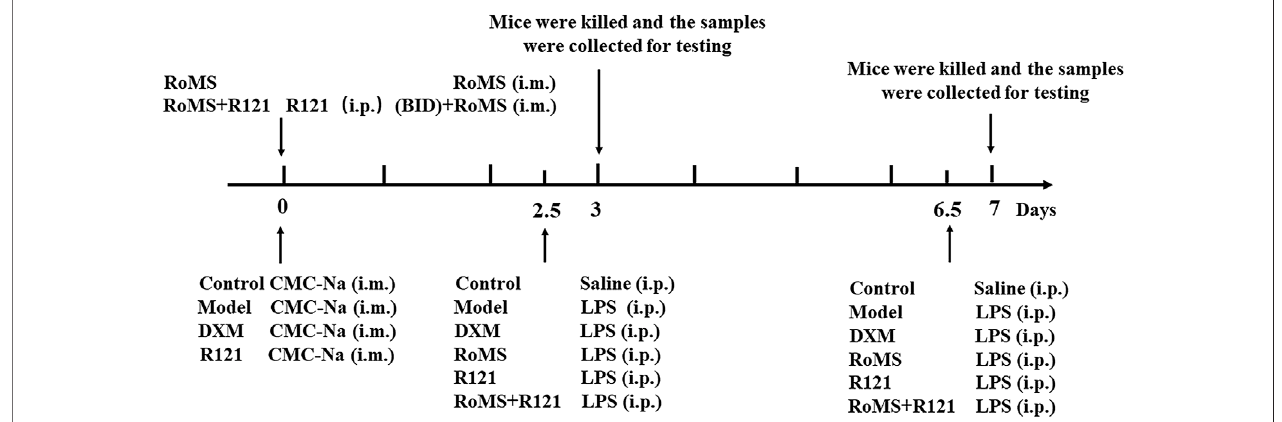
FIGURE 1 | Schematic diagram of the experimental